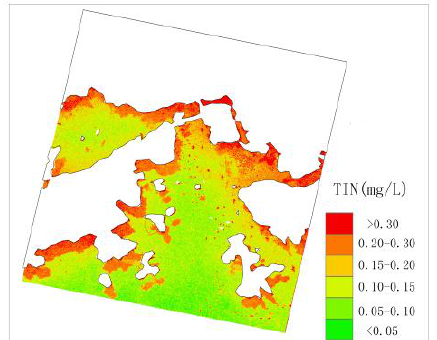
Figure 4. Distribution of TIN in sea surface of study